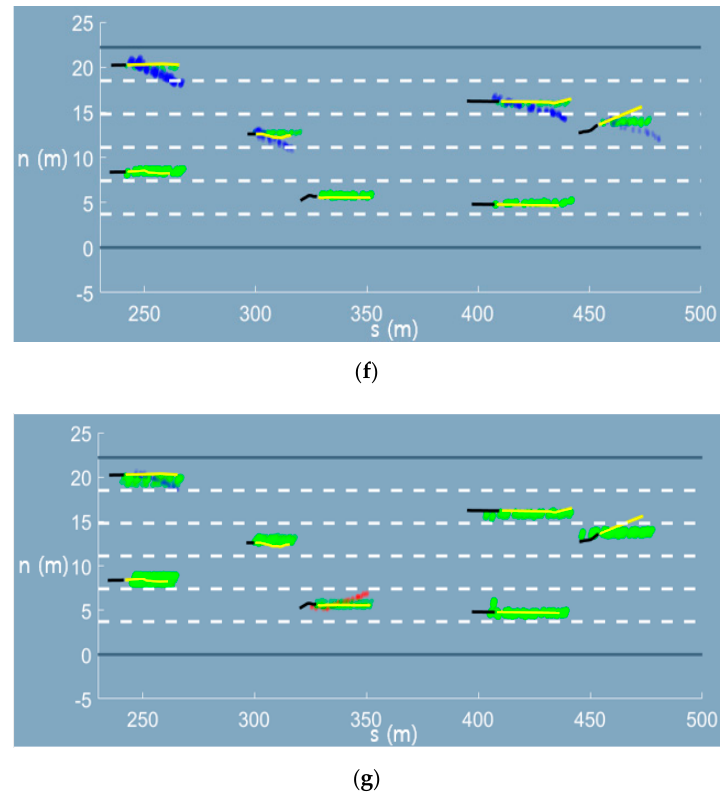
Figure A2. Comparative results of the trajectory prediction network. ( a – g ) are the results obtained by learning from 5%, 10%, 15%, 20%, 40%, 60%, and 80%, respectively, of the training dataset. The bigger and more apparent the marker, the higher the confidence level of the maneuver.